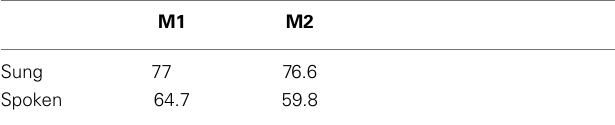
Table 2 | Percentage means of recalled words at M1 and M2